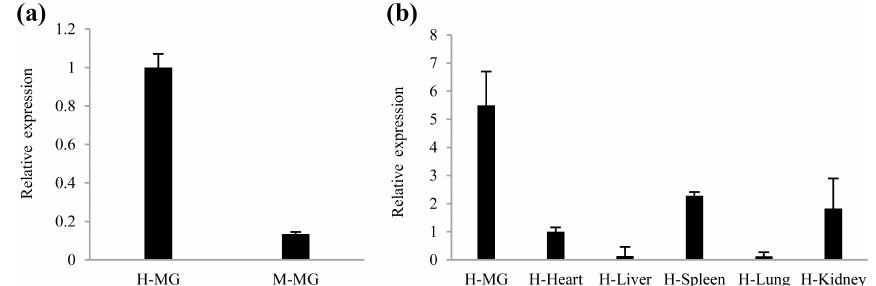
Figure 2. Relative expression of miR-144-5p . (a) Relative expression of miR-144-5p in healthy and mastitis-infected mammary gland tissues using qPCR. H-MG denotes healthy mammary gland and M-MG denotes mastitis-infected mammary gland. (b) Relative expression of miR- 144-5p in a variety of healthy tissues using qPCR. H denotes the healthy cow group. The vertical bar represents the standard error.